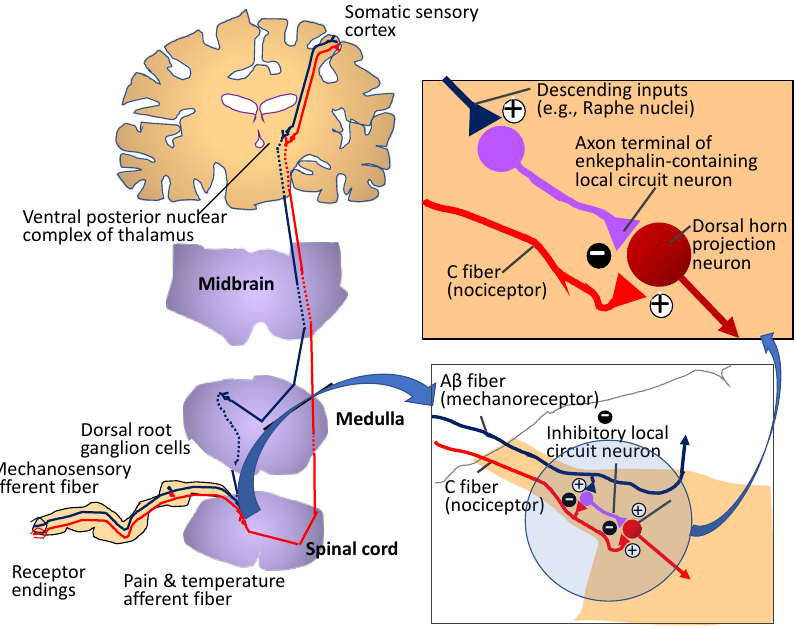
Figure 4. A discriminative pain pathway and mechanosensory pathway (adopted from Figures 10.6 ( A ) and 10.8 ( B , C ) in